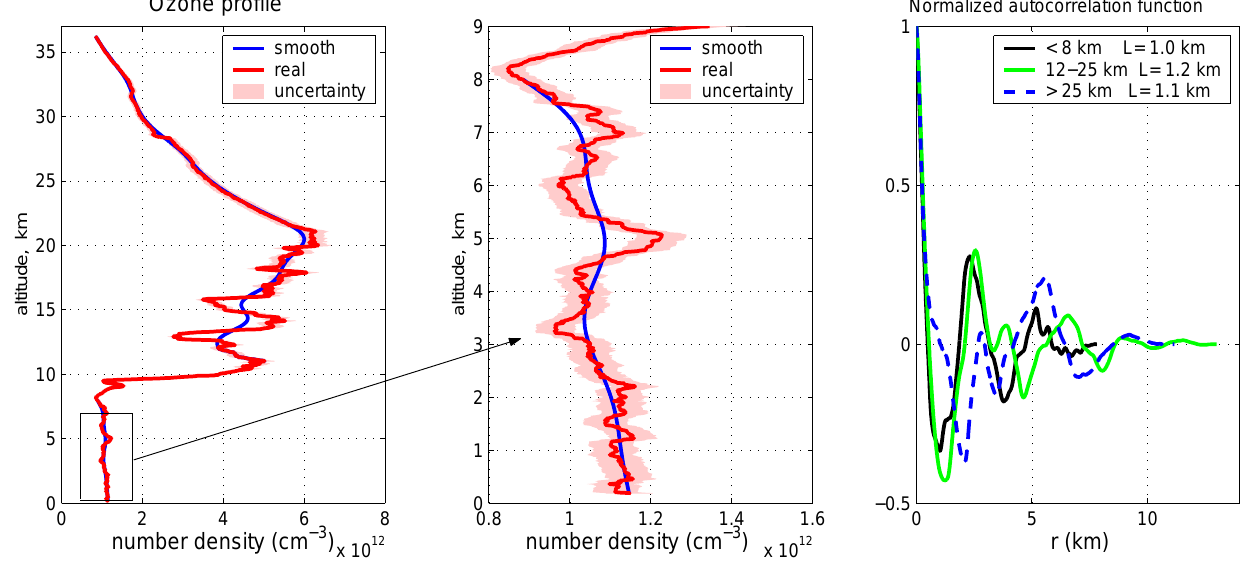
Fig. 1. Data processing for determination of the characteristic scale of the ozone fine structure. Left and central plot: measured and smoothed ozone profiles. Right: autocorrelation functions for the three altitude